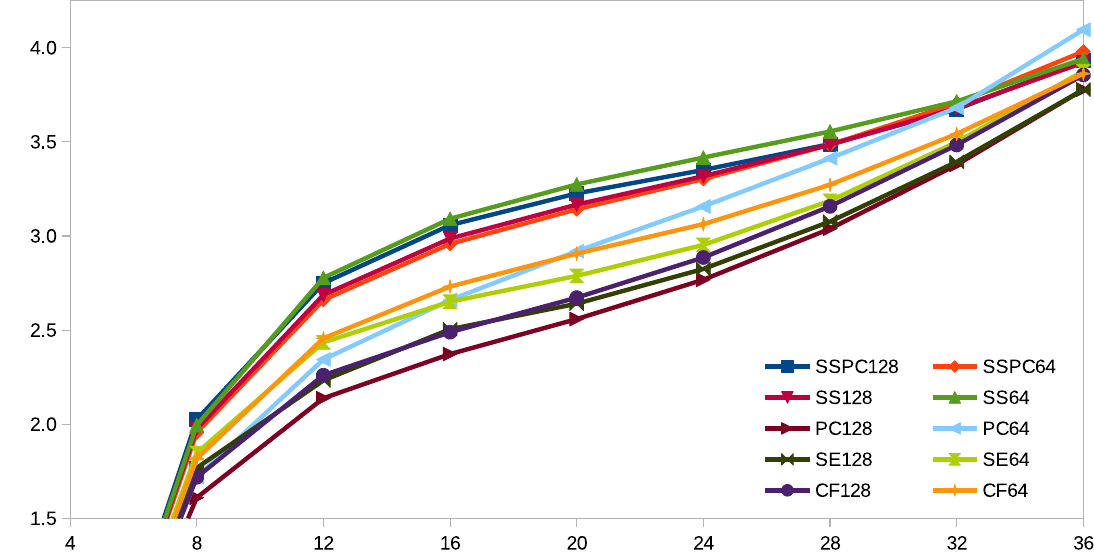
Figure 2. MAE values (y-axis) obtained by SDP variants over inter-residue distances in [0, h ) where h is a threshold